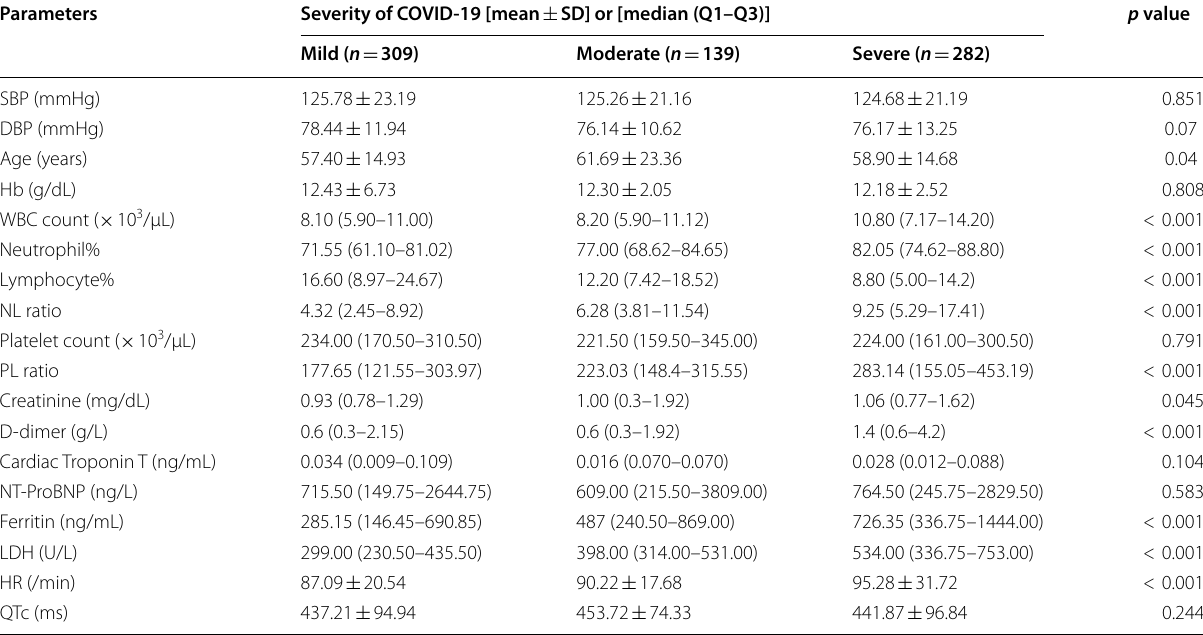
Table 5 Demographic data, laboratory investigations and ECG changes among the severity of COVID-19